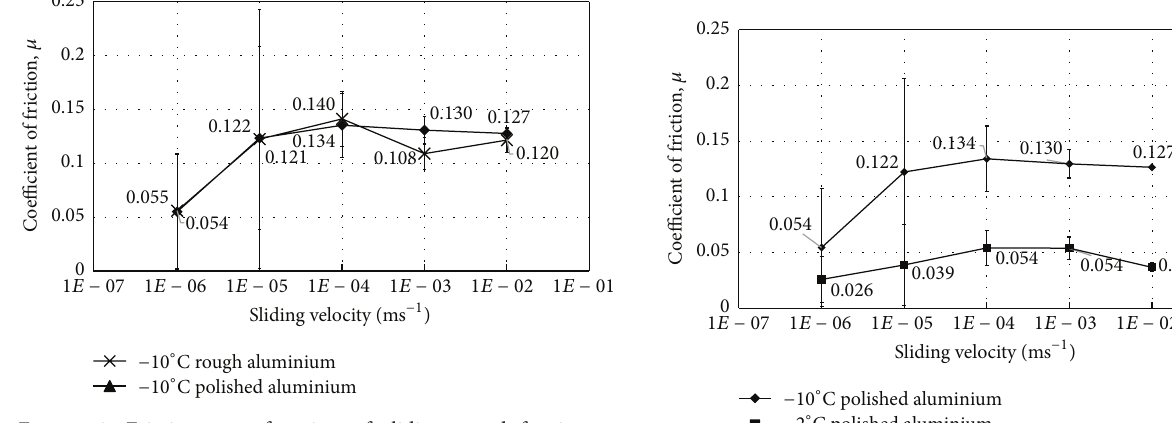
Figure 9: Friction as a function of sliding speed for ice on aluminium, showing results for rough and polished aluminium at − 10 ∘ C.